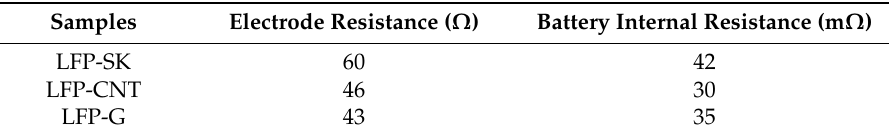
Table 1. Electrode and battery